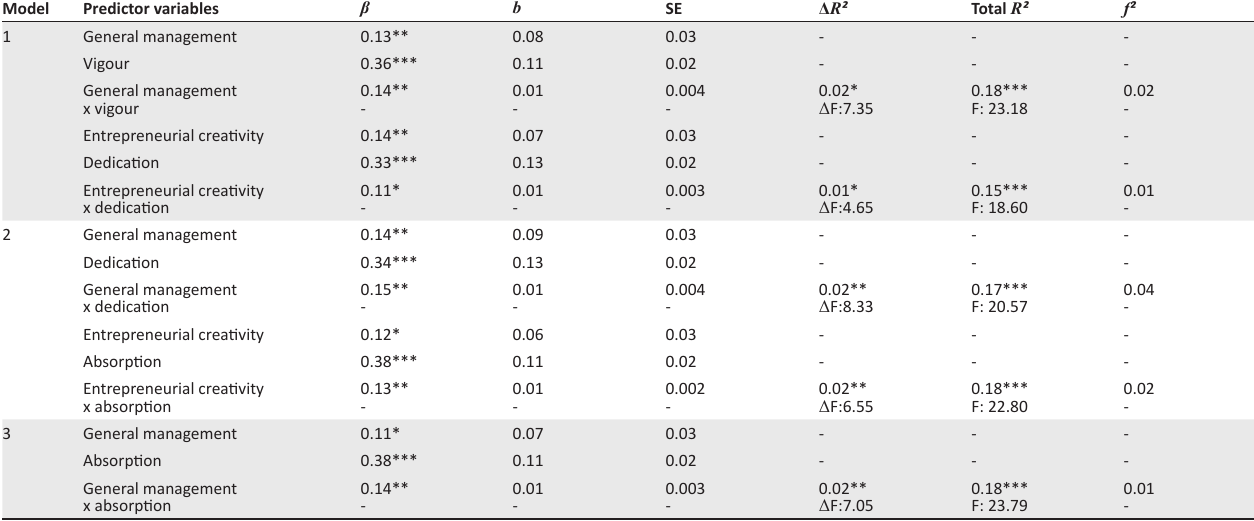
TABLE 3: Moderated regression analysis examining the interaction effects between the general management and entrepreneurial creativity career anchors and vigour, dedication and absorption (work engagement) on job commitment.